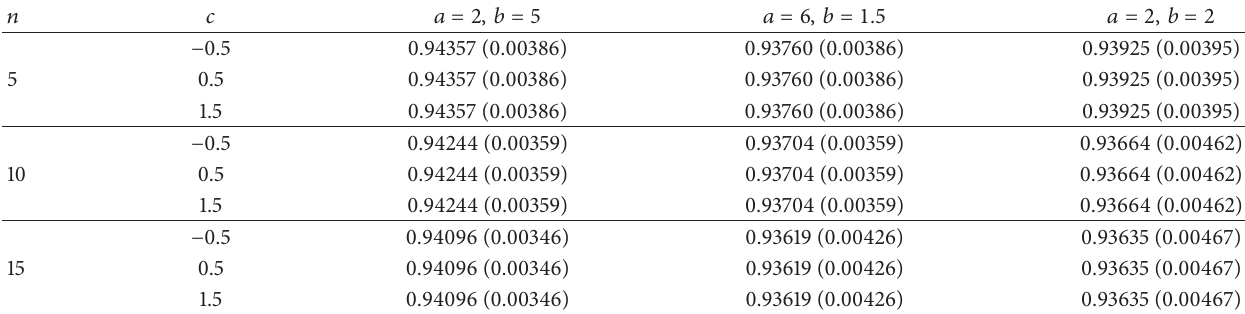
Table 4: Average empirical credible level (1 − 𝛼) for 𝐶 𝐿 under LINEX loss function when 𝛼 = 0.05 .